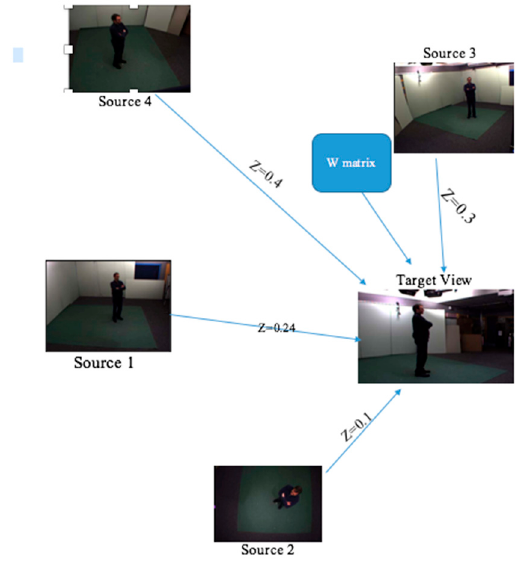
Figure 5. Extracting the features from source pictures and creating the target view (image retrieved from the public dataset IXMAS).